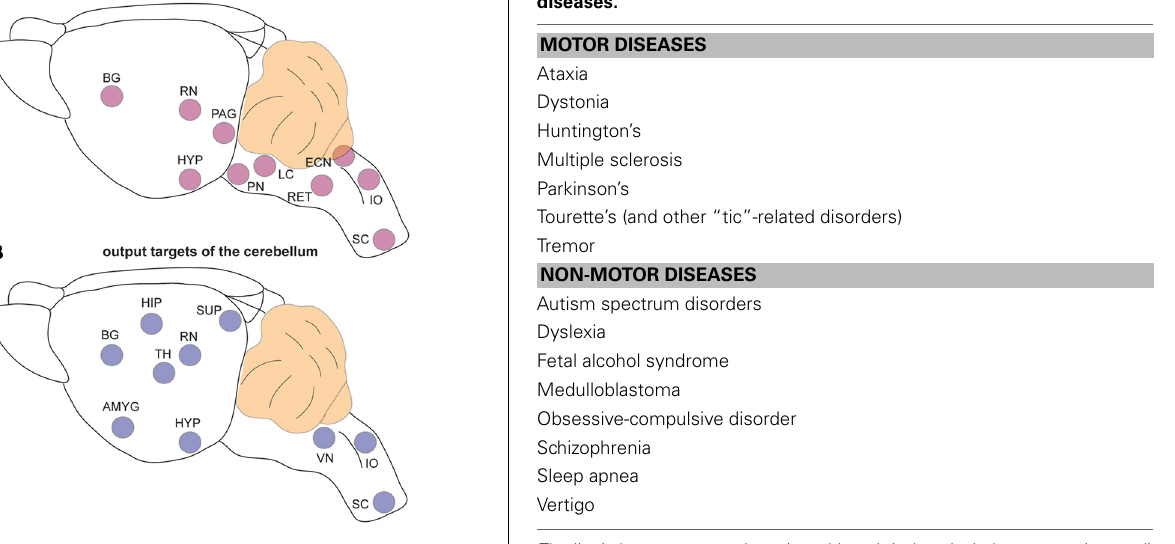
FIGURE 3 | The cerebellum is extensively connected to the brain and spinal cord. (A) Schematic representation of brain regions that send input to the cerebellum. (B) Schematic representation of the regions that receive information from the cerebellum. Note that the TH is a major relay station for cerebellar input to the cortex while the PN is the primary gateway for cerebral cortical input to the cerebellum. Abbreviations: AMG, amygdala; BG, basal ganglia; ECN, external cuneate nucleus; HIP, hippocampus; HYP; hypothalamus; IO, inferior olive; LC, locus coeruleus; PAG, periaqueductal gray; PN, pontine nuclei; RET, reticular nucleus; RN, red nucleus; SC, spinal cord; SUP, superior colliculi; TH, thalamus; VN, vestibular nuclei.